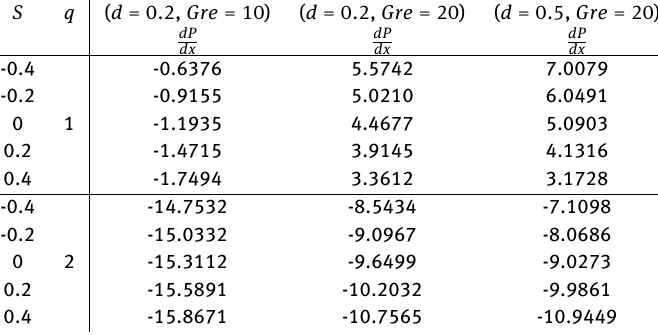
Table 1: Variation of pressure gradient( dP